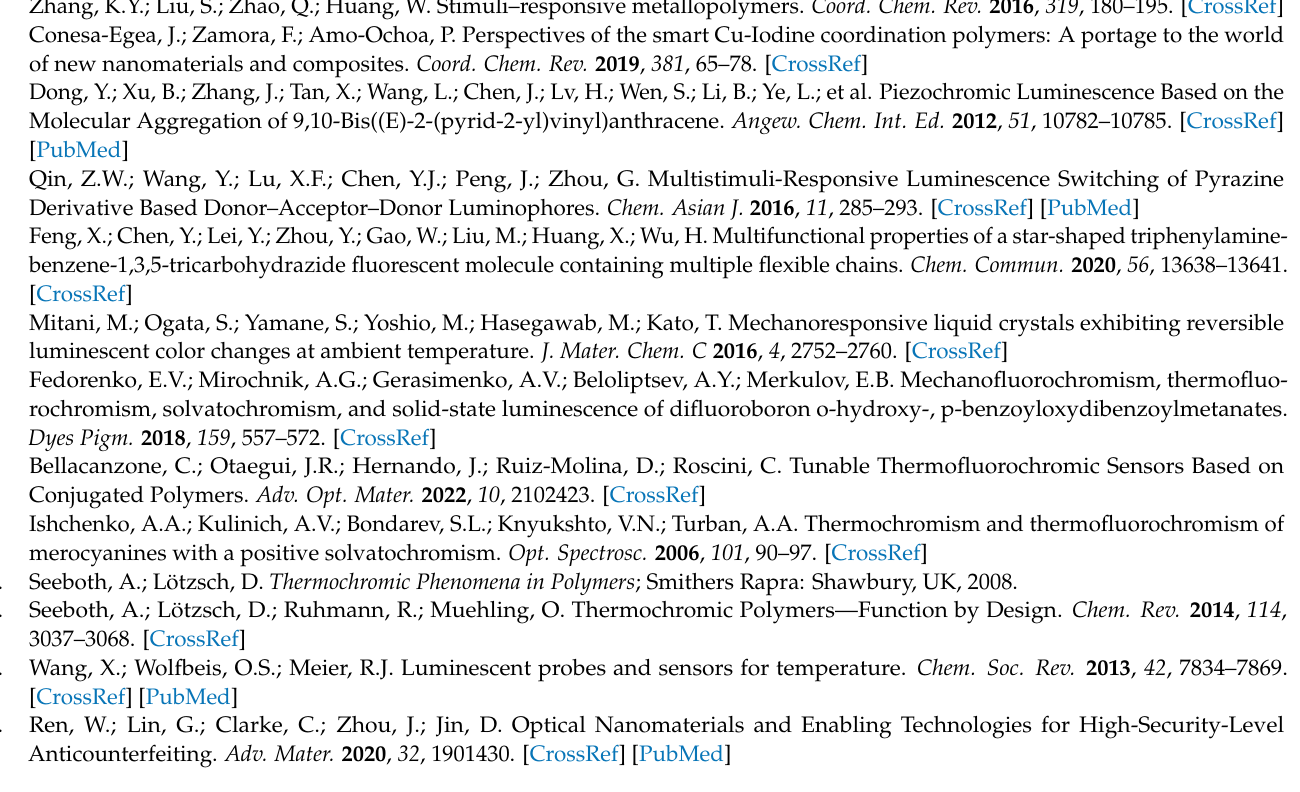
ologens; Figure S1: Representative POM images of the textures of the compound 9VBF 4 acquired on cooling from the isotropic liquid state at 5 ◦ C/min; Figure S2: DSC thermograms of the sample 9VBF 4 . The phase transitions experienced by the sample in the first heating scan (not reported) are monotropic; Figure S3: TGA of the sample 9VBF4; Figure S4: WAXS profiles of the sample 9VBF 4 , recorded during the second and successive heatings and coolings steps. The phase transitions experienced by the sample in the first heating scan (not reported) are monotropic. The diffraction peak at 2 θ ≈ 5 ◦ indicates that the smectic period corresponds to 20.3 Å.; Figure S5: Emission spec- tra in dichloromethane solution at different concentrations; Table S1: Photophysical properties of mVX2 thienoviologens in dichloromethane solution. Figure S6: Temperature-dependent 1931 CIE chromaticity coordinates of the fluorescent emission of 9V(OTs), 10V(OTs), 10V(OTf), 11V(OTf), 12V(NTf 2